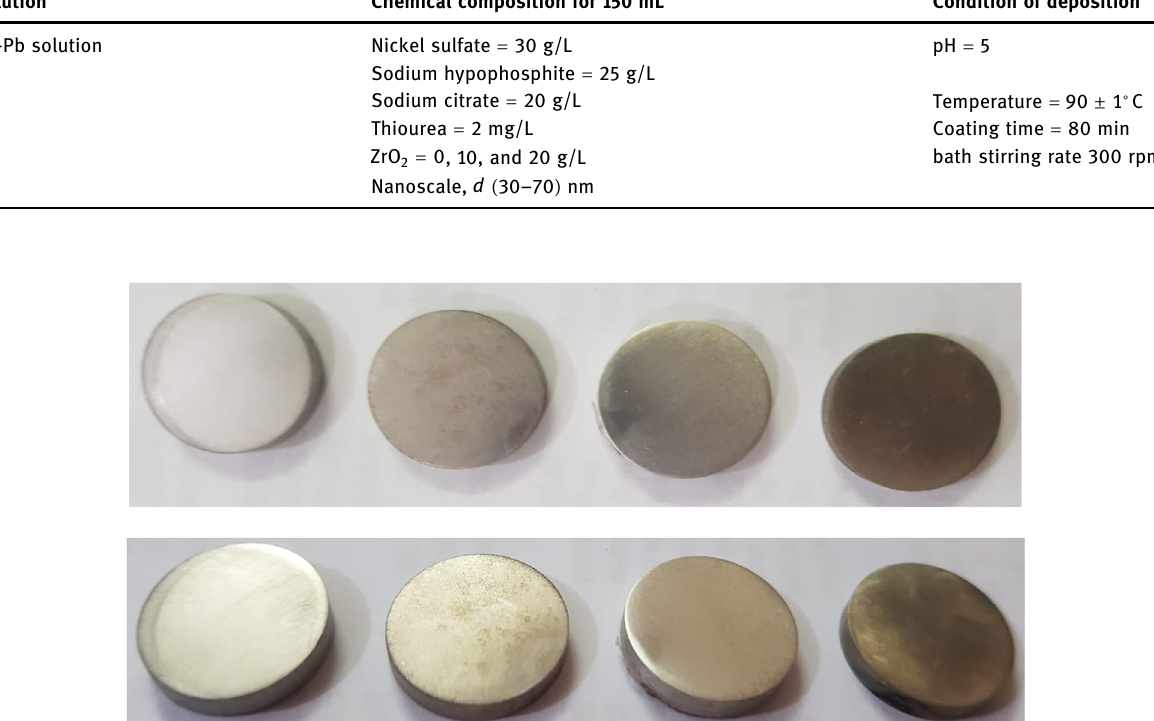
Figure 1: The samples after the coating